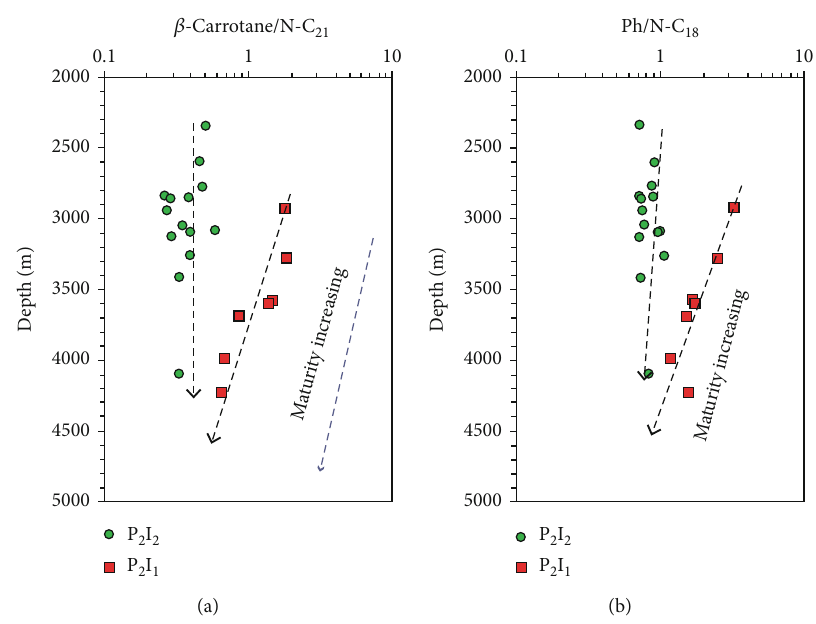
Figure 12: Cross-plots of (a) β -carrotane/ n -C